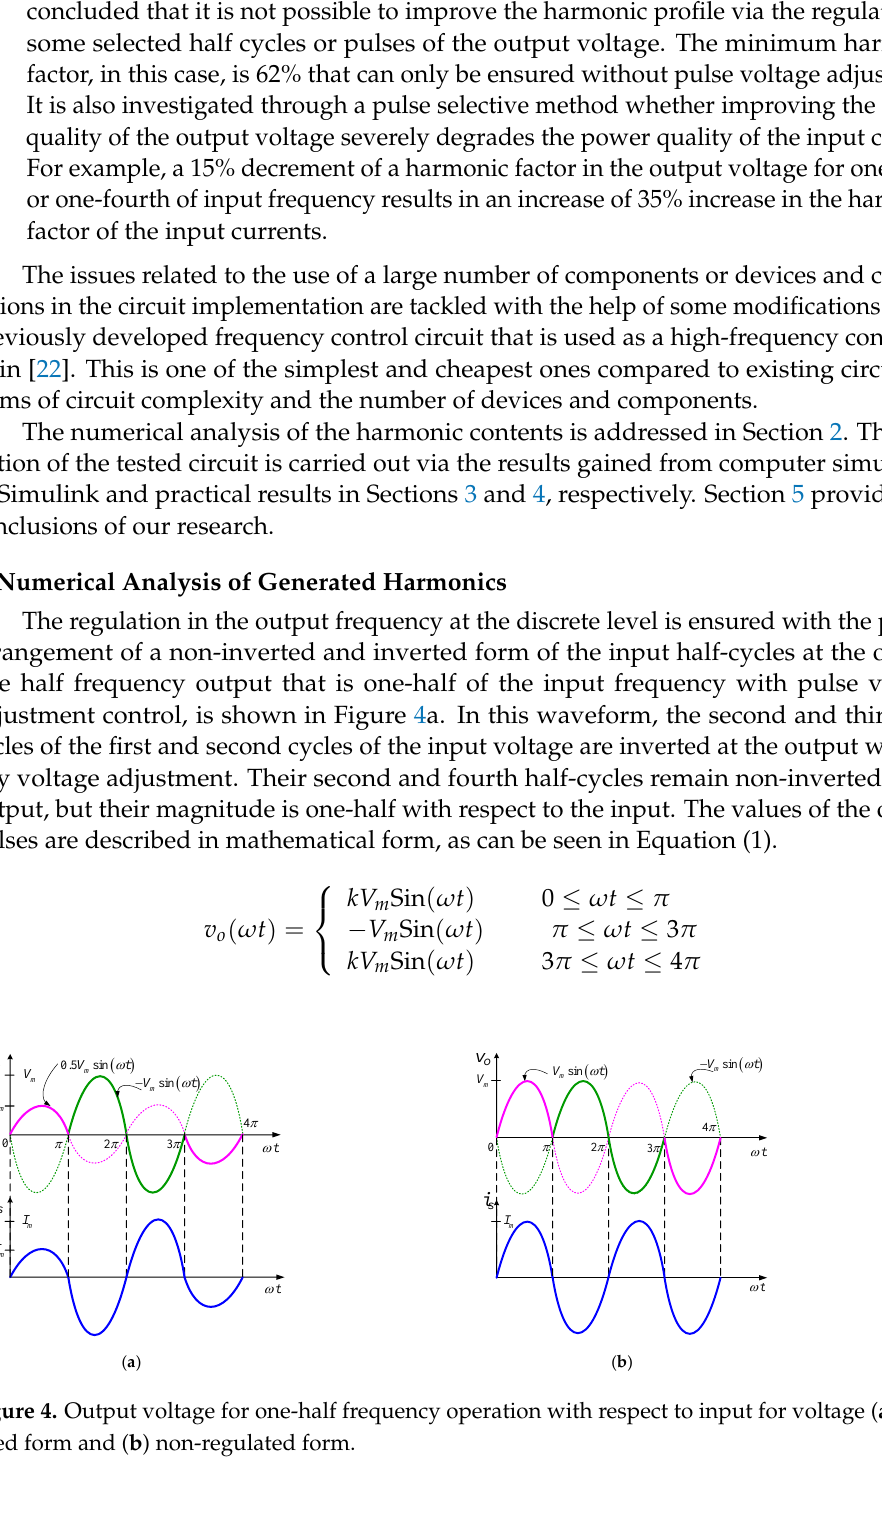
Figure 4. Output voltage for one-half frequency operation with respect to input for voltage ( a ) regulated form and ( b ) non-regulated form.